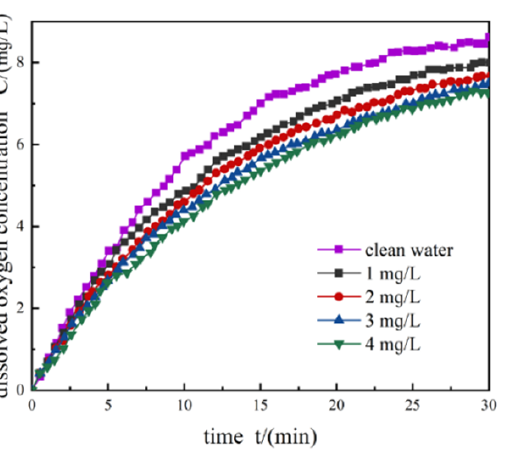
Figure 9. The dissolved oxygen concentrations at different sludge concentrations.